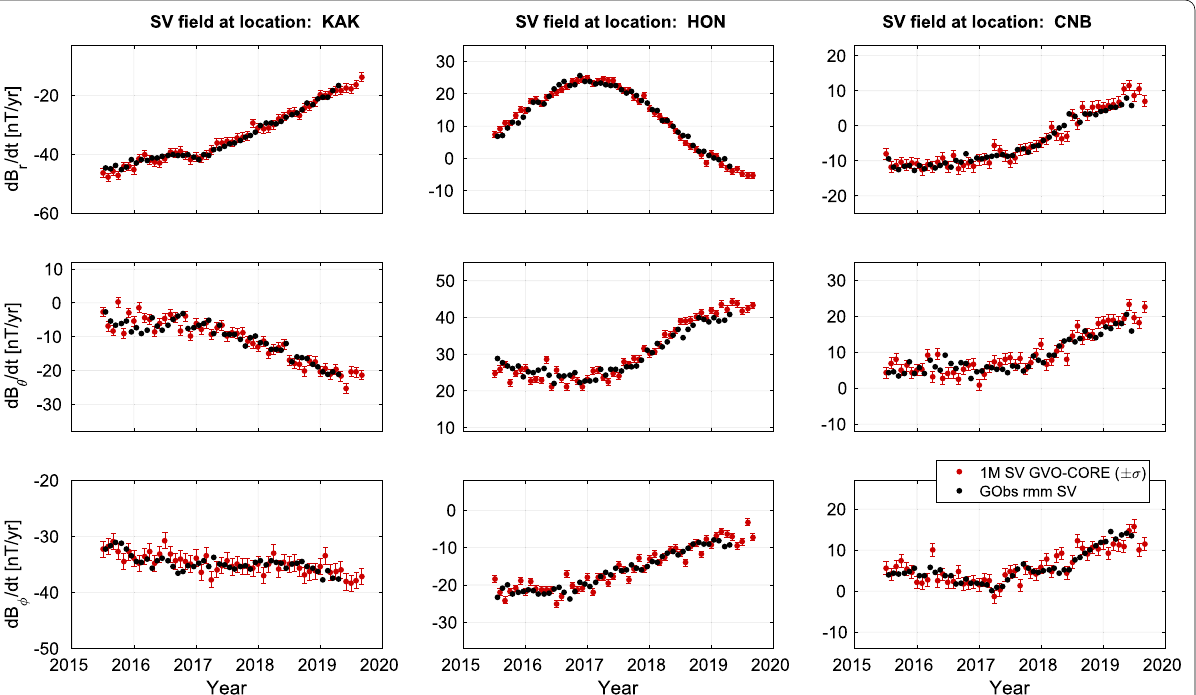
σ uncertainties, and revised monthly means from selected ±